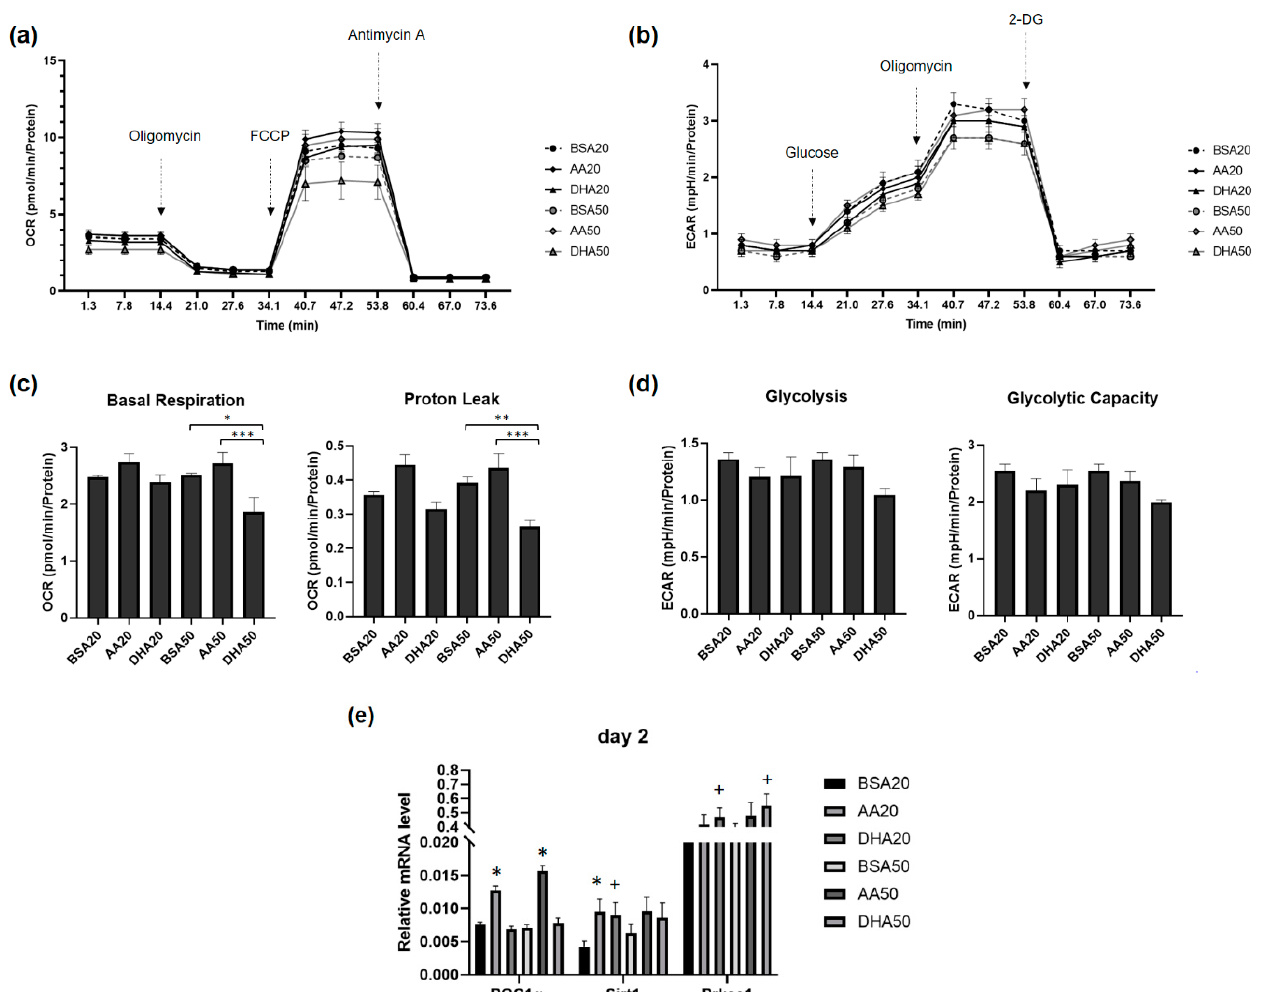
Figure 8. Bioenergetics metabolism in C2C12 under 2 days of AA and DHA treatments. ( a ) Mitochondrial respiration and ( b ) Glycolytic function in C2C12 cells in culture with different treatments; AA20, AA50, DHA20, DHA50, the controls BSA20 and BSA50. ( c ) The effect of AA50 and DHA 50 on the basal respiration and proton leak. ( d ) No effect of PUFA treatments on the glycolysis and glycolytic reserve. All data are from six well of 3000 cells/well per treatment. All values are LS means ± SEM given in pmol O 2 /min/ µ g protein. * p < 0.1, ** p < 0.05 and *** p < 0.001. ( e ) The mRNA levels of PGC-1alpha , Sirt1 and Prkaa1 ; the mRNA levels of PGC-1alpha were significantly increased with AA treatments in both concentration (20 and 50 μ M). The mRNA levels of Prkaa1 were significantly increased with DHA20 and DHA50. Sirt1 mRNA levels were significantly increased with DHA and AA with 20 μ M. All values are LS means ± SEM, + p < 0.1 and * p < 0.05.